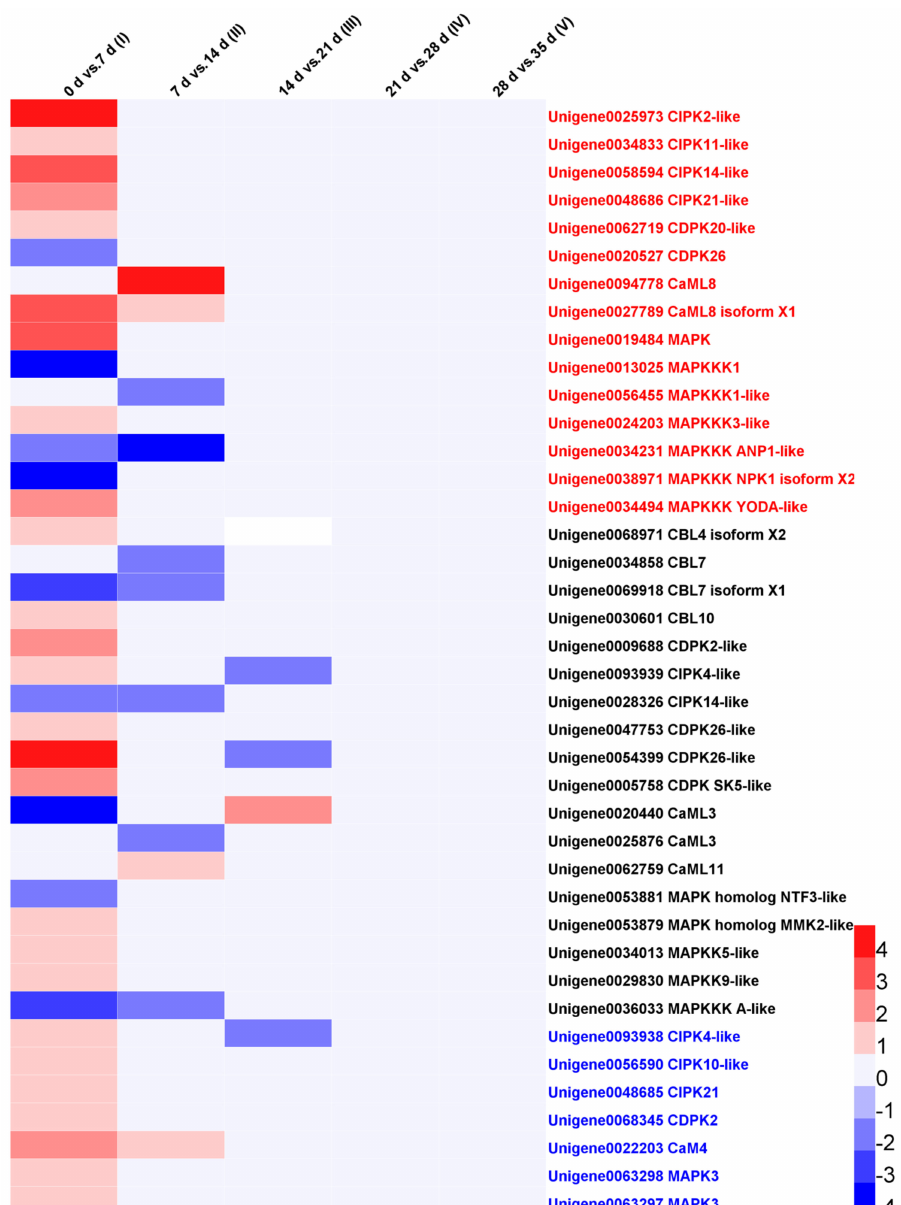
Figure 5. The heatmap showed the DEGs expression abundance of Ca 2+ signal components in five stages of cold-stored loquat fruits. Different colors represents the log 2 (fold change) value of the DEGs in the stages. Different right-label colors represents the reads per kilobase per million reads (RPKM) value of the DEGs. Red: low expression abundance genes (RPKM < 5); black: moderate expression abundance genes (5 ≤ RPKM < 50); blue: high expression abundance genes (RPKM ≥